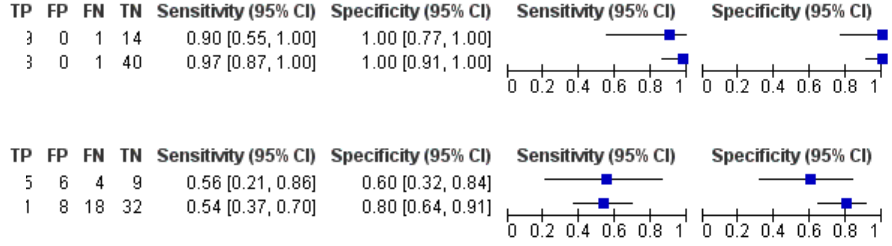
Figure 7. Forest plots demonstrating the sensitivity and specificity of PO and EPT [11,12].